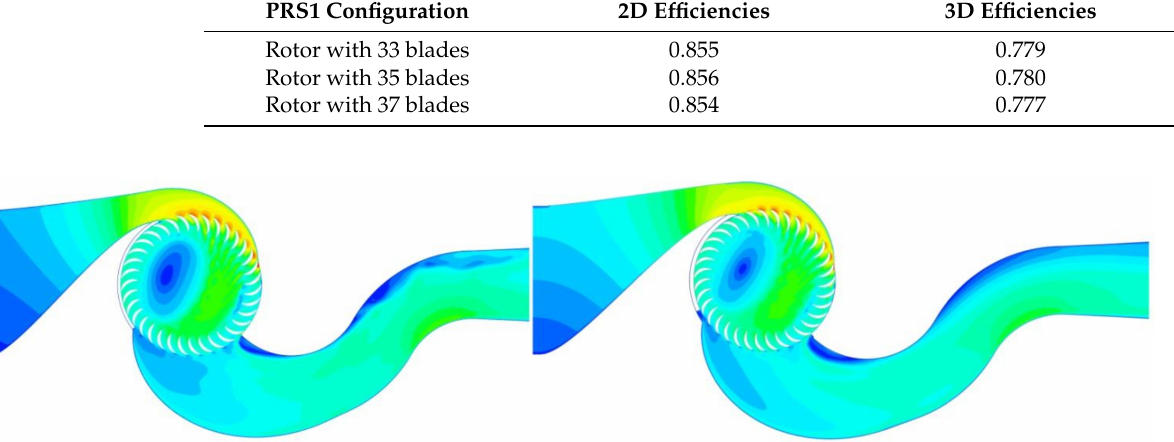
Figure 4. Velocity field in the 3D (left) and 2D (right)